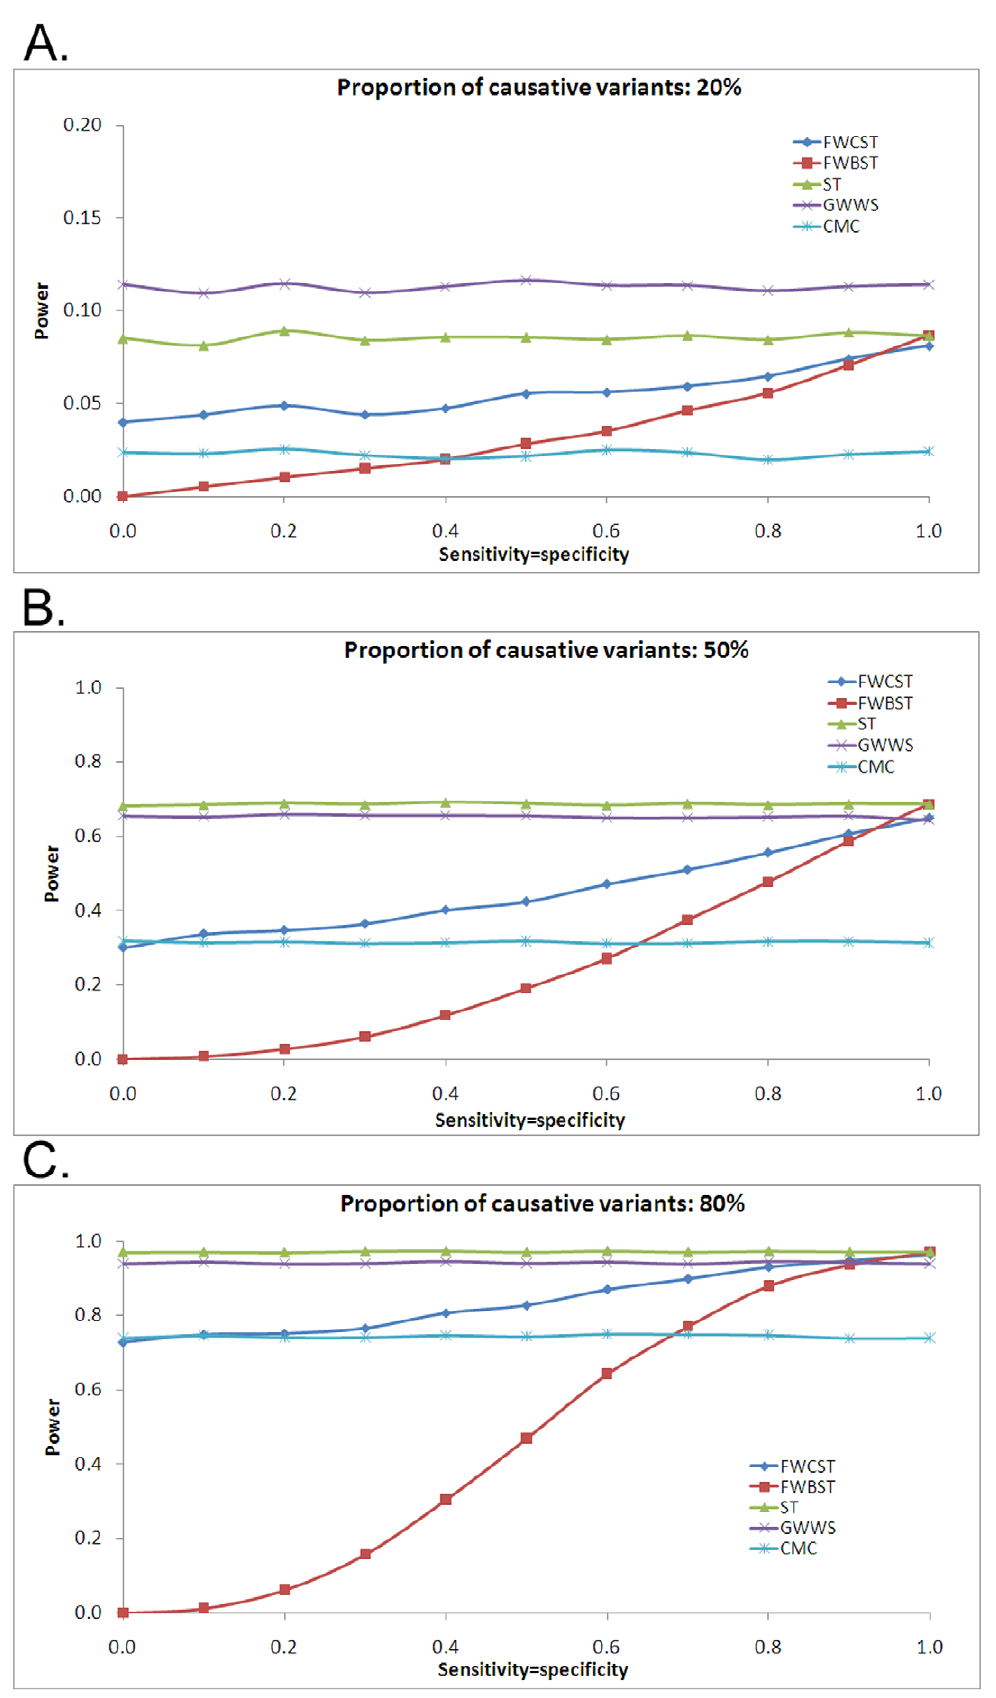
Figure 7. Power with equaling effective proportion of causative variants. The sensitivity and specificity are set to be equal, in order to retain the effective proportion of causative variants after weighting to that without weighting. See the legend for figure 4 for abbreviations and simulation detail. doi:10.1371/journal.pone.0013857.g007 PLoS ONE |